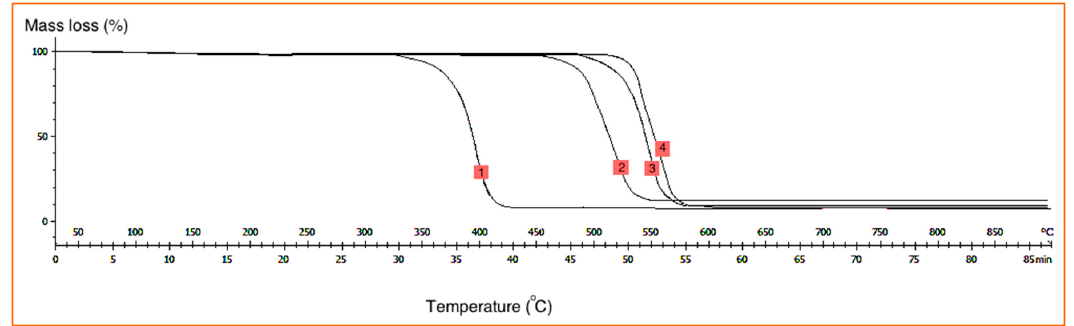
Figure 10. TGA graphs of the various polymer composites (1: PP; 2: CNS/PP; 3: CNS-MLG/PP and 4: CNS-FLG/PP); Horizontal axis: Temperature (°C); Vertical axis: Loss weight percentage (wt %).